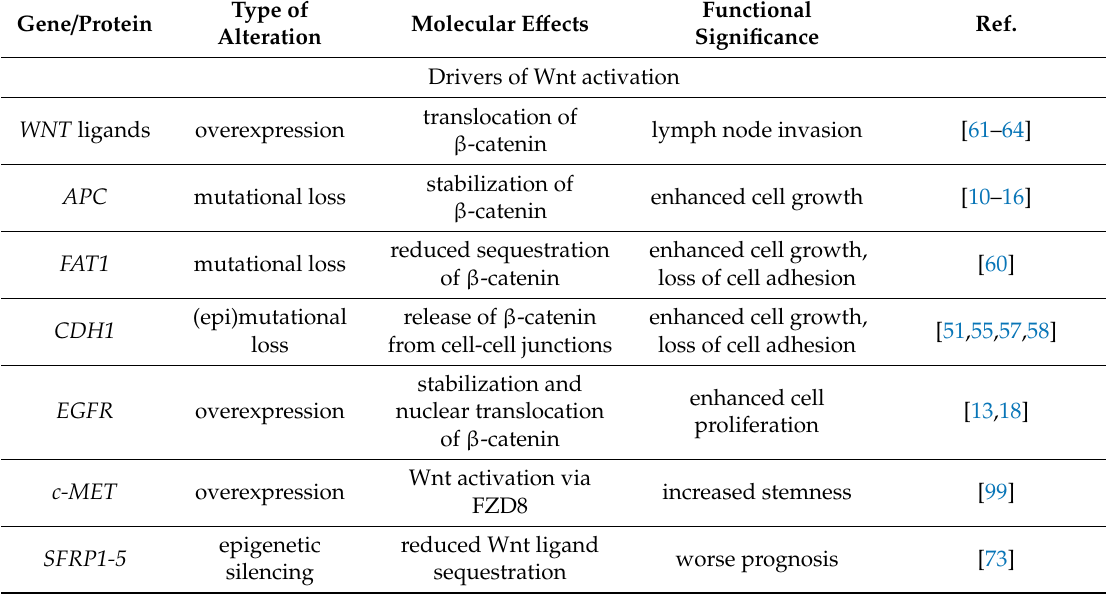
Table 1. Key molecular alterations related to canonical Wnt pathway activation in